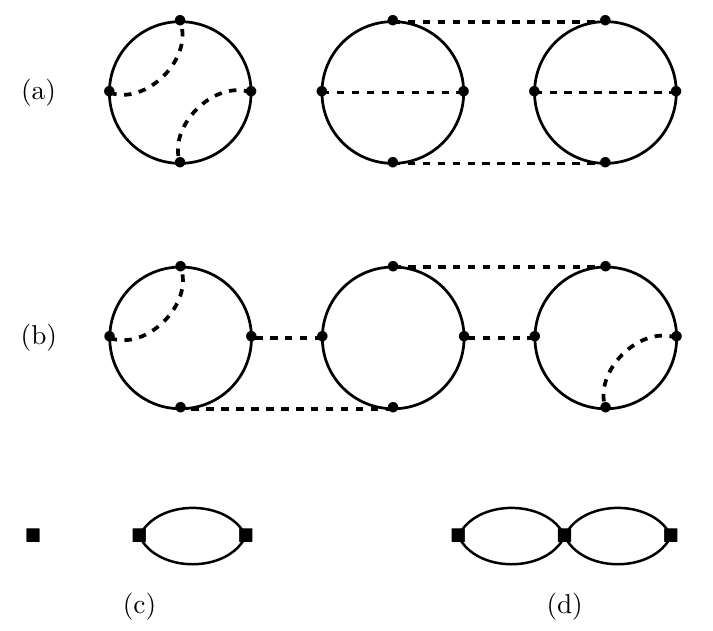
Figure 1 . Two different chord diagrams that contribute to the moment M (4 , 4 , 4) . (a) and (b) are the full chord diagrams, while (c) and (d) are their contracted diagrams respectively. Diagram (b) (or it’s contraction (d)) is connected while diagram (a) (or its contraction (c)) is